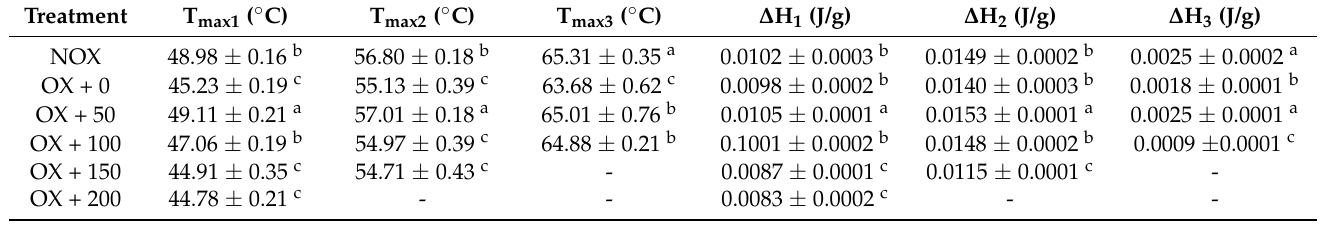
Table 3. Thermal ability of MPs prepared with FOs (0, 50, 100, 150, and 200 µ mol/g protein) under nonoxidizing (NOX) or oxidizing (OX) conditions analyzed by DSC. Different lowercase letters indicate significant differences ( p < 0.05).